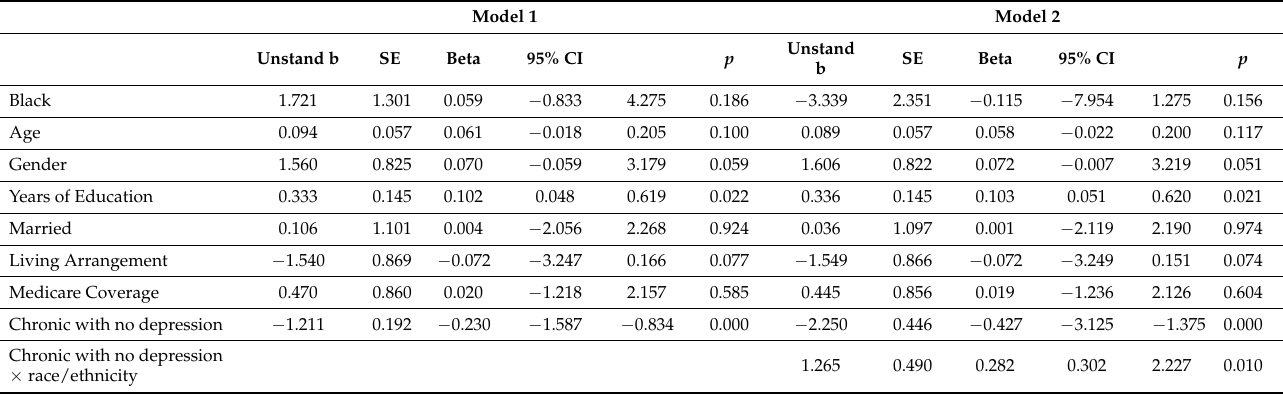
Table 3. Linear regression on mental health-related quality of life as the outcome.